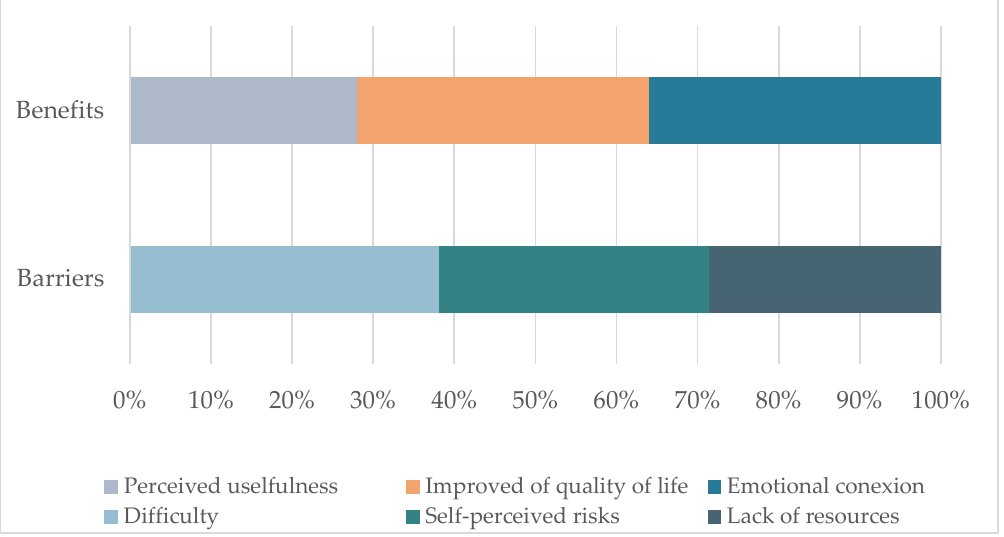
Figure 4. Main results of their perceptions of technological resources in the time of COVID-19.